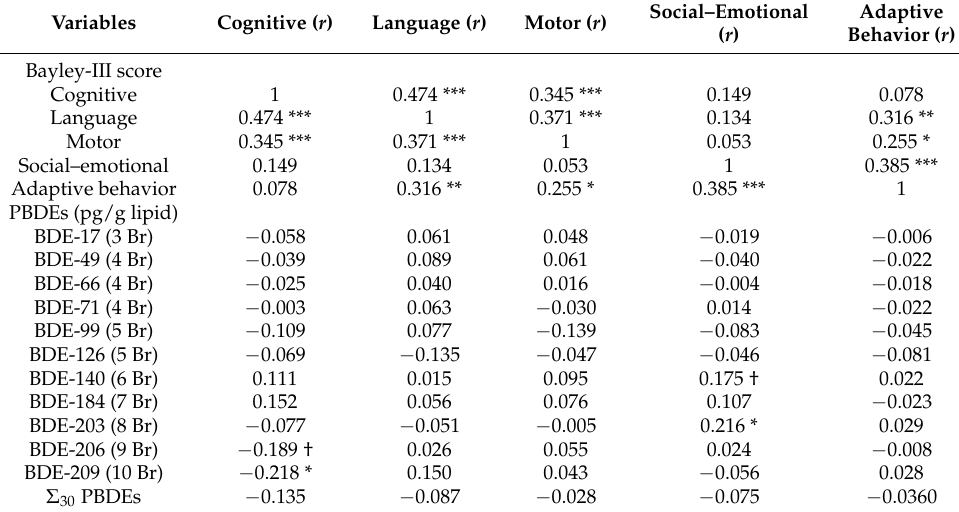
Table 3. Descriptive statistics and Spearman correlation of PBDEs with the five domains of the Bayley-III score (n =